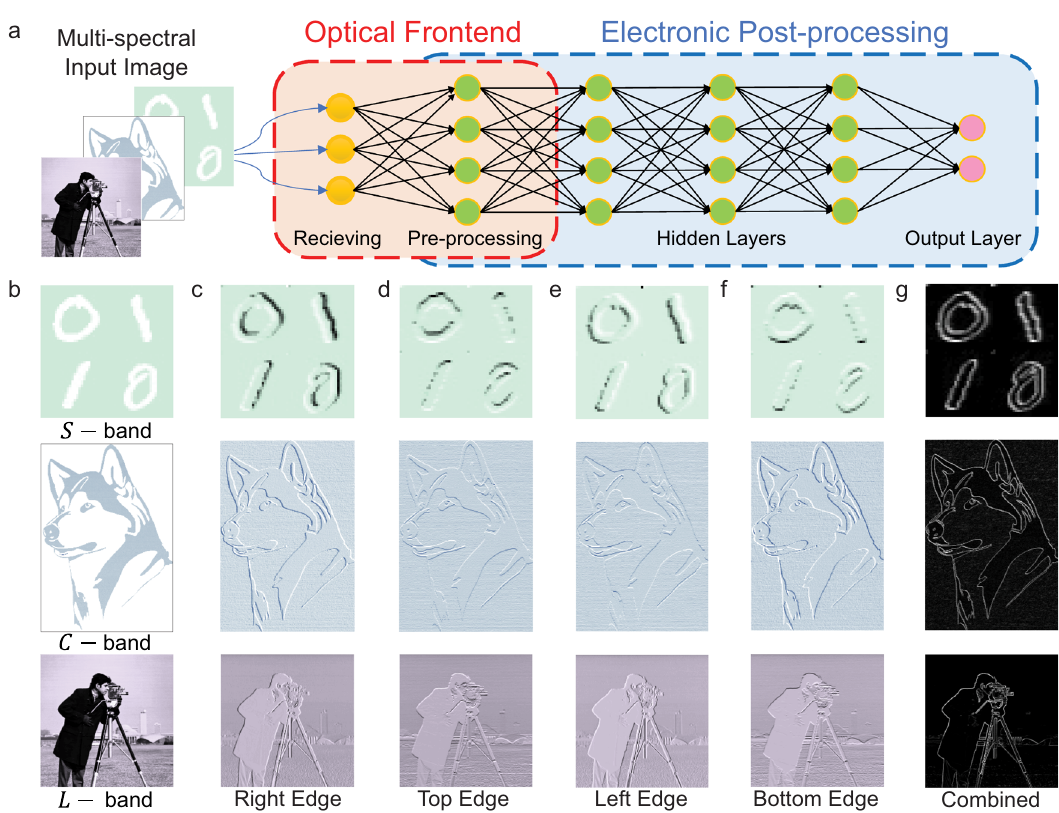
Fig. 3 bP-PPT array for imaging with in-sensor computing for edge detection. a The bP-PPT array receives images in multiple wavelength bands. The array ’ s photoresponsivity matrix is programmed to represent the convolution kernel to directly preprocess the images in the optoelectronic domain (red dashed line box). The array ’ s conductance matrix is then programmed to perform inference computation in the electrical domain (blue dashed line box). b The original input images encoded in the optical power transmitted in three different telecom bands. Top: handwritten digits (56 × 56 pixels, S -band); middle: a husky dog (312 × 222 pixels, C -band); bottom: a cameraman (256 × 256 pixels, L -band). c – f The resultant images after convolution with the right, top, left, and bottom edge kernels, respectively. g The fi nal images combining all the